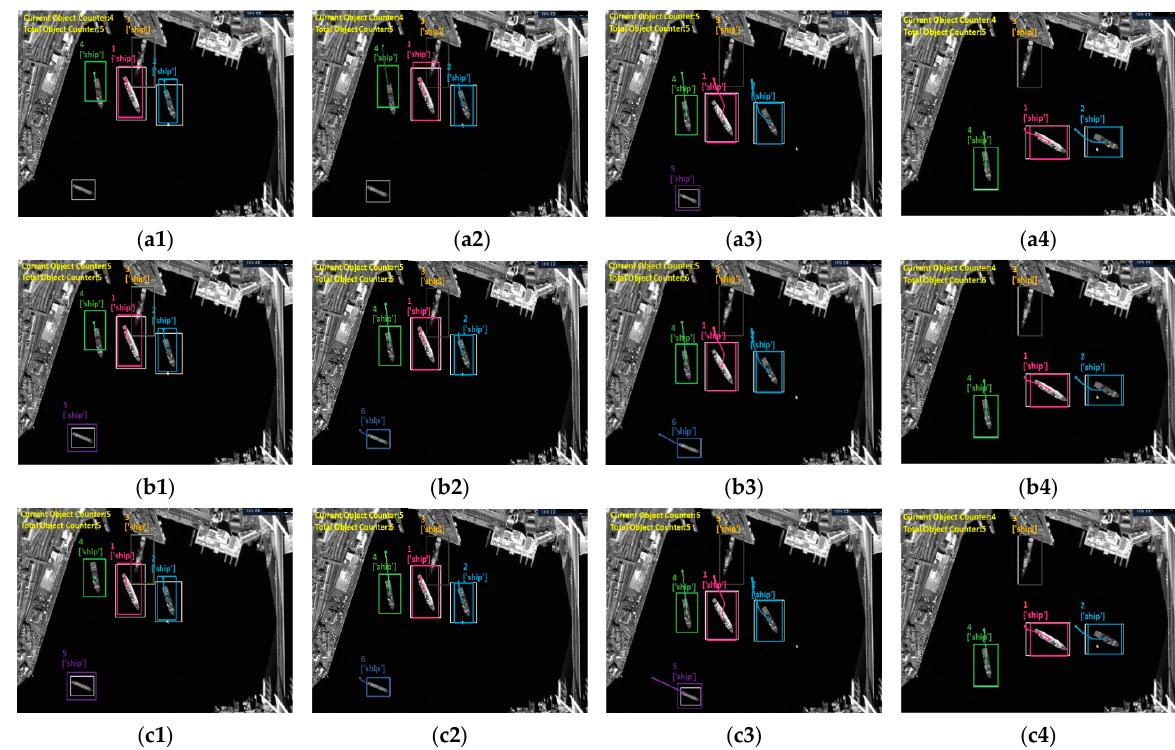
Figure 8. Tracking results of one frame on the dataset using different algorithms: ( a1 – c1 ): the 12th frames; ( a2 – c2 ): the 24th frames; ( a3 – c3 ): the 53rd frames; ( a4 – c4 ): the 62nd frames; ( a1 – a4 ) the tracking results of the SORT model; ( b1 – b4 ) the tracking results of the DeepSORT model; ( c1 – c4 ) the tracking results of the model proposed in this paper.